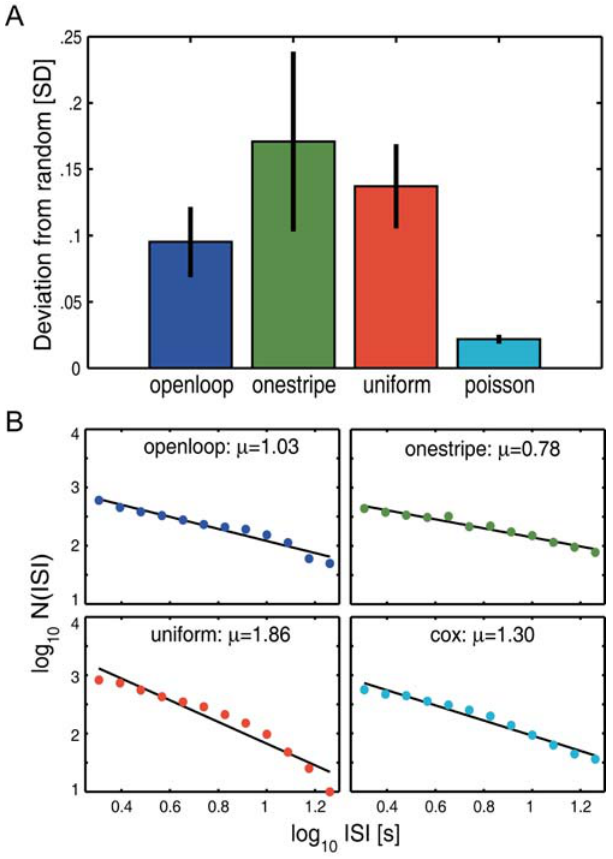
Figure 3. Spontaneous behavior is not simply random. A–GRIP analysis of ISIs. Plotted are the mean standard deviations from the theoretically expected random value for fly ISI series and the random series generated by a Poisson process. The fly deviations are all significantly larger than the values for the computer-generated series. B–Log-log plots of ISIs. The Le´vy exponent m is calculated from the inclination of the linear fit. A Le´vy distribution is defined as 1 , m , 3. Smaller values indicate a larger proportion of long ISIs. A Cox Process ( cox ) reveals a similar power-law structure as the flies. Error bars are S.E.M.s throughout. See Methods for details and